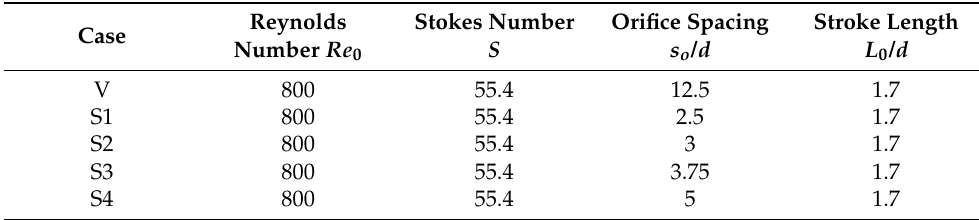
Table 2. Summary of the numerical cases: V is the validation case, S1–S4 refer to the parametric analysis in terms of the orifice spacing.